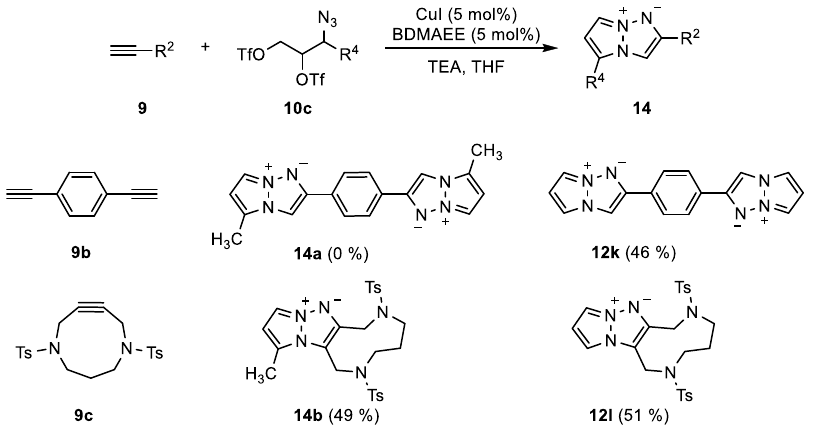
Scheme 5. The synthesis of 2,4-disubstituted TAPs 14 and corresponding 4-unsubstituted TAPs. R 4 = Me or Ph.